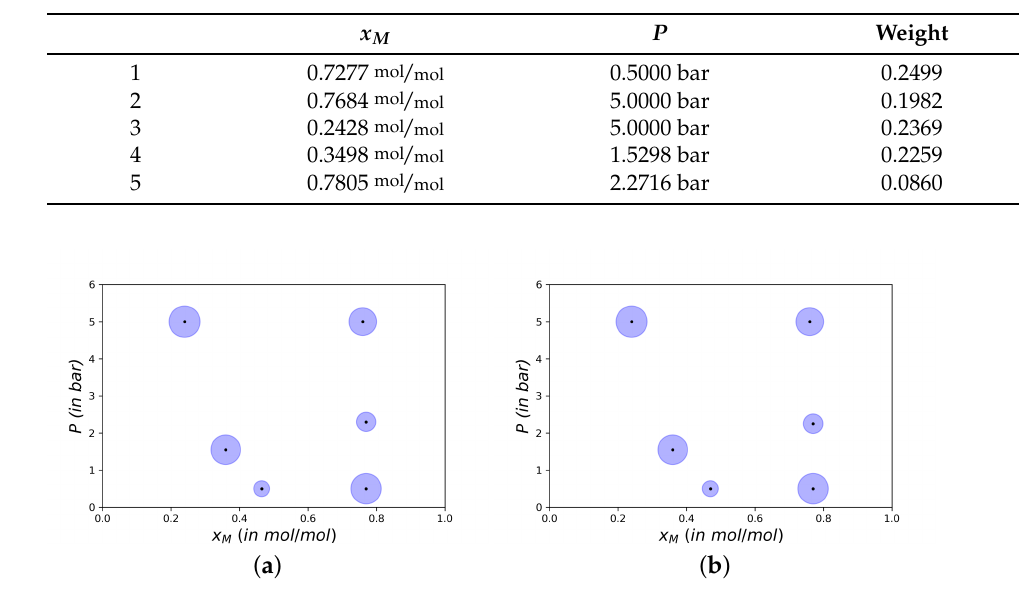
Figure 6. Optimal designs in the two-dimensional design space for the flash with a methanol–acetone input feed. ( a ) The design ξ VDM computed with the VDM. ( b ) The design ξ YBT computed with the YBT